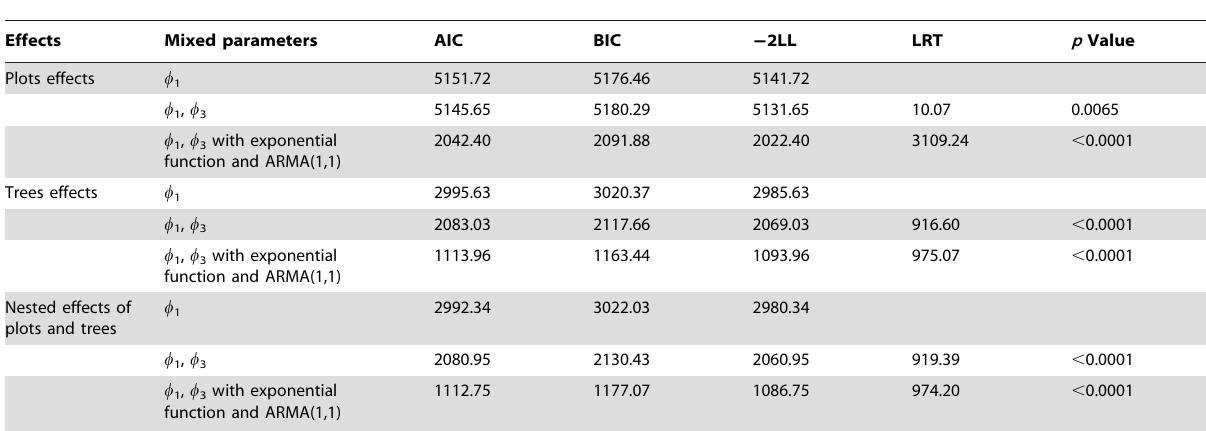
Table 5. Performance criteria for the best NLME